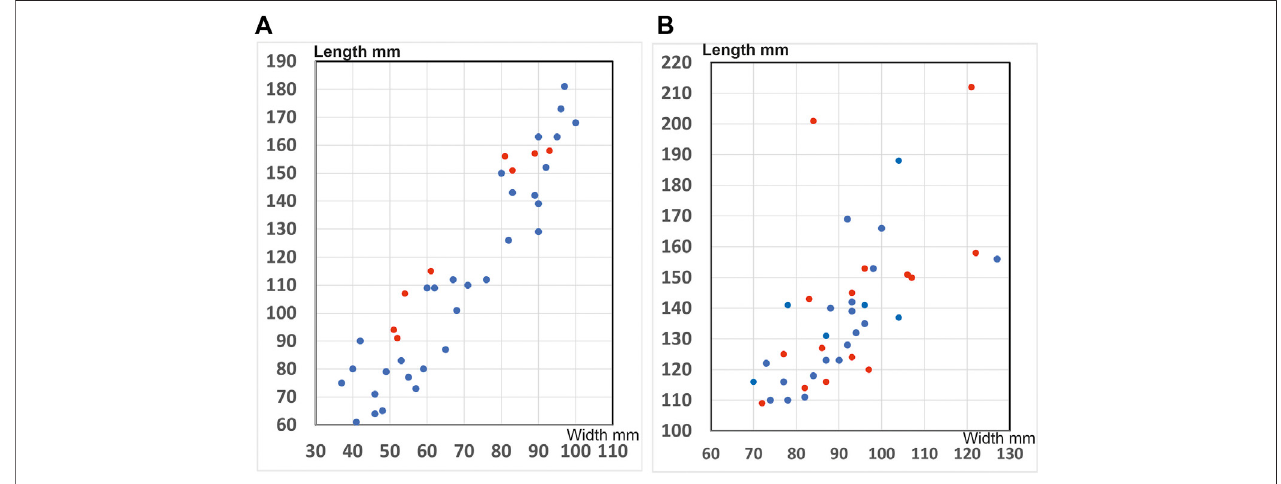
FIGURE8| Scatterplotoflengthandwidthmeasurementsoftheunfracturedhandaxes (A) andcleavers (B) . (A) Reddot,pointedhandaxes.Bluedot,non-pointed handaxes. (B) Red dot, types 0 and I of cleavers. Blue dot: type II of cleavers and variants.